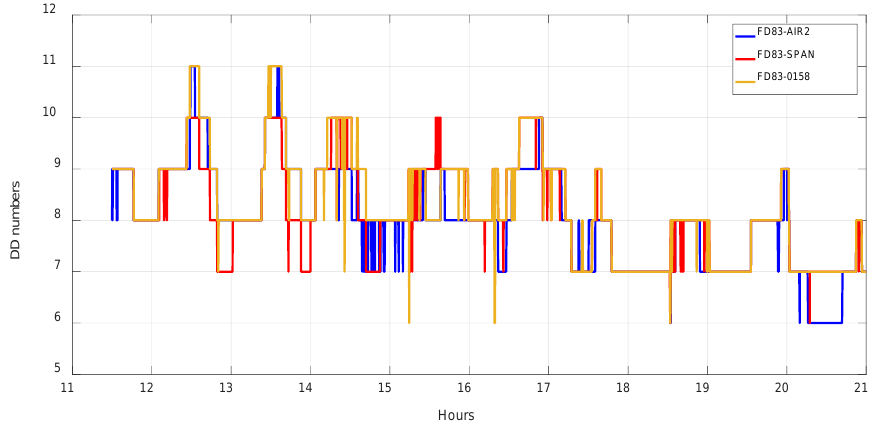
Figure 10. The number of DD observations used in the processing for the three baselines. During 20:00–21:00, the number is 6 and is not beneficial for the calculation of DD solutions.